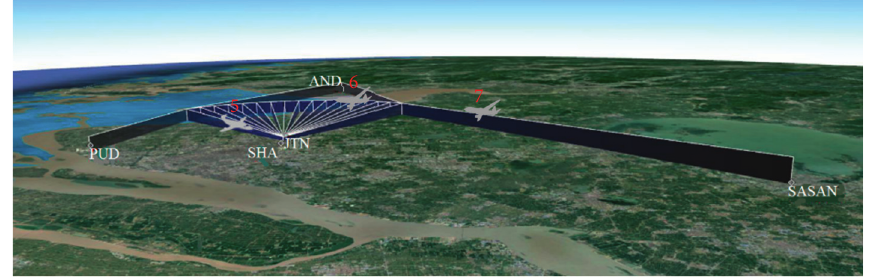
Figure 17: Aircraft flying along the sequencing leg.